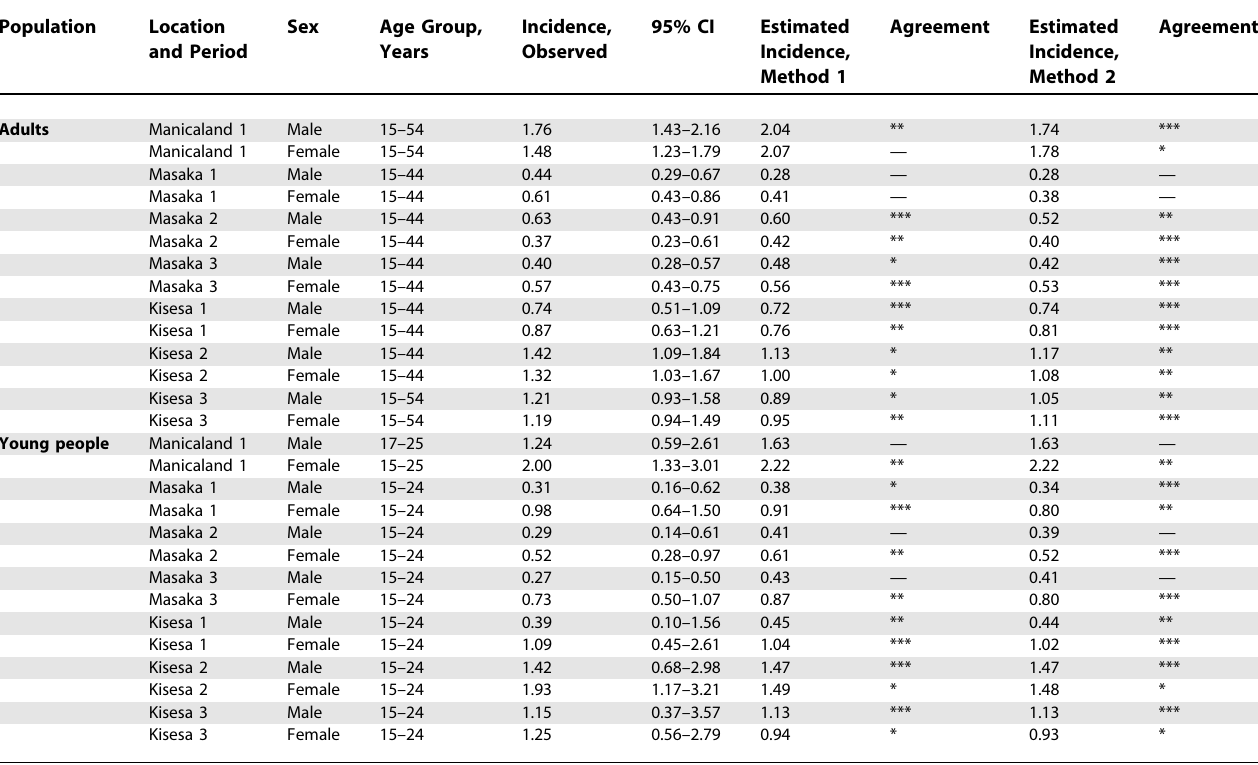
Table 3. Measurements and Estimates of Incidence in